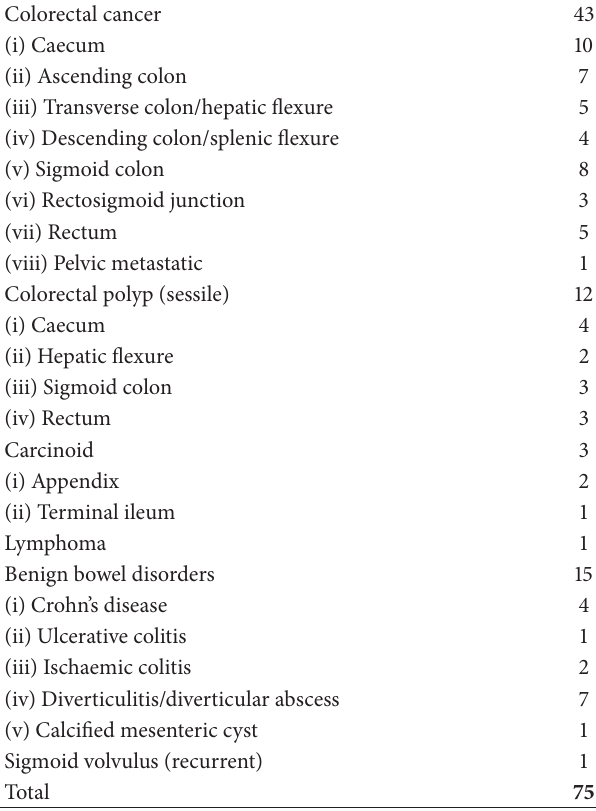
Table 2: Indications for surgery.